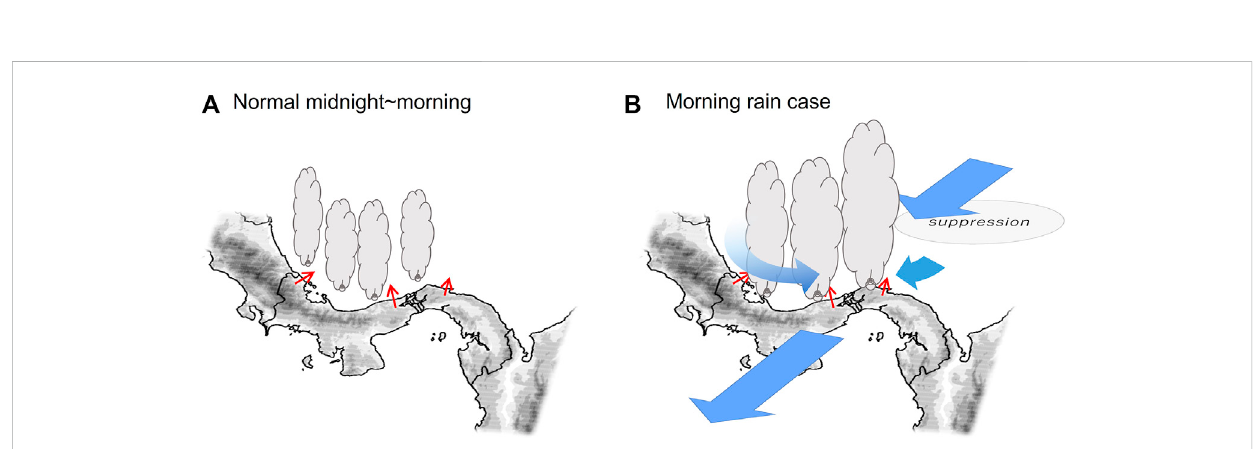
FIGURE 11 Conceptualdiagramof theoccurrence ofmorning rains in thenorth partof theUpper Chagres River Basin. The normal state during themidnightto early morning (A) and the morning rain case (B) . Blue (red) vectors indicate anomalous winds (land breeze).